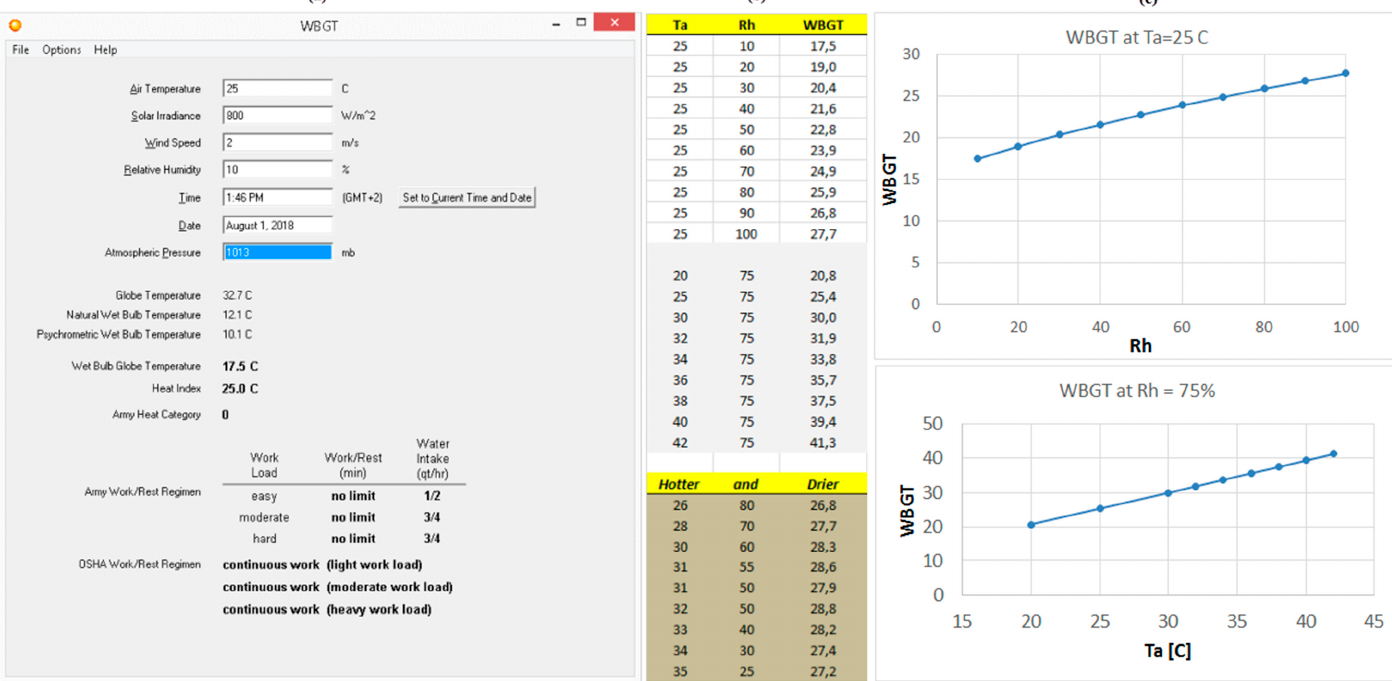
Figure B2. Assessing the sensitivity of WBGT to air temperature (Ta) and relative humidity (Rh): ( a ) the interface for the software “WBGT” developed by Liljegren et al. (2008) [53]; ( b ) input data, air temperature (Ta) and relative humidity (Rh) used for the assessment of WBGT; ( c ) plots of the WBGT response to relative humidity (Rh) and to air temperature (Ta) .